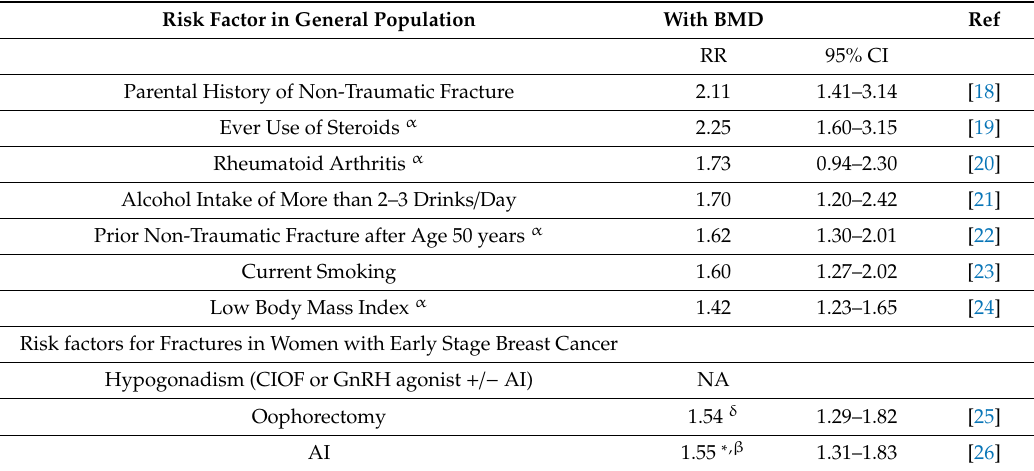
Table 1. Risk Factors for